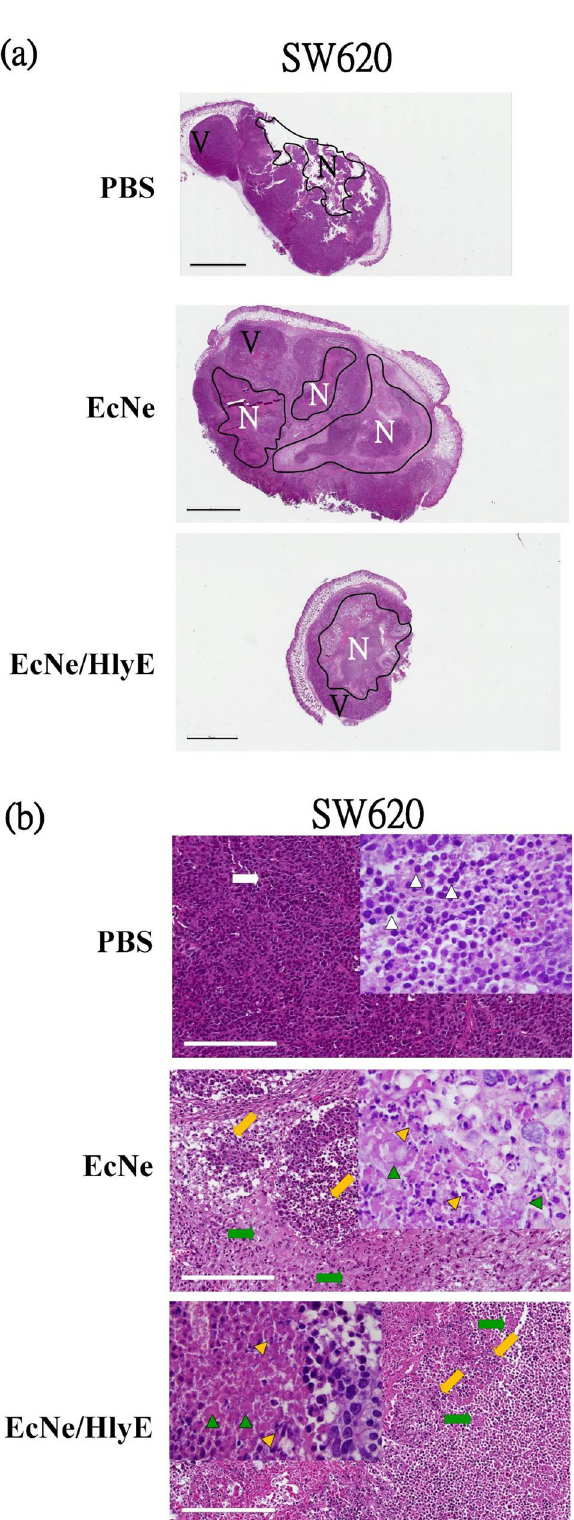
Figure 6. H&E staining of tumor tissues and organs . H&E staining was applied to analyze nuclear chromatin (purple-blue) and cytoplasm (red). ( a ) Tumor tissues of SW620 cells after receiving various treatments. The necrosis (N) and viable (V) regions of tissues were marked (bar = 3 mm). Imag J software was applied to measure the total cross-sectional area of each tumor and the area of necrosis present in each tumor. ( b ) High-resolution micrographs for necrosis regions of SW620 tissues (bar = 200 μm). Nuclear condensation (pyknosis), nuclear fragmentation (karyorrhexis), and nuclear dissolution (karyolysis) were observed as indicated by white, yellow, and green arrows, respectively. ( c ) Tumor tissues of HT29 cells after receiving various treatments. ( d ) High-resolution micrographs for necrosis regions of HT29 tissues. ( e ) Histopathological morphology of liver. ( f ) Histopathological morphology of